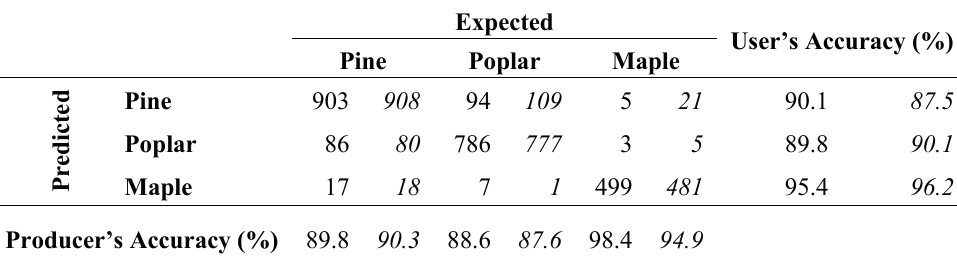
Table 5. Confusion matrix for ensemble classification, Bold number: geometric classifier as first classifier (average accuracy of 91.2%); italic numbers: vertical profile classifier as first classifier (average accuracy of